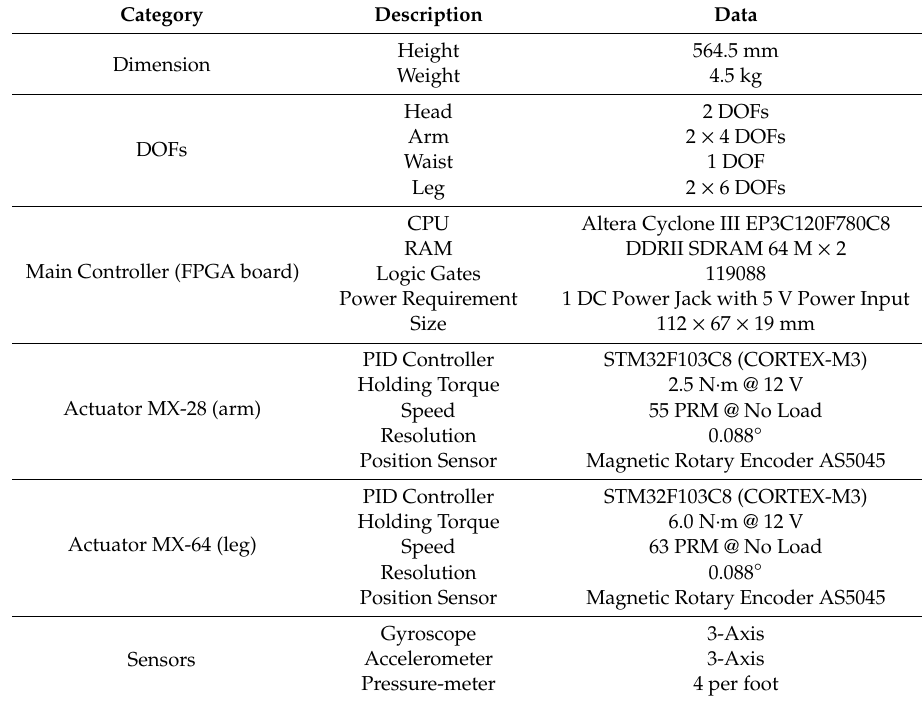
Figure 2. Dimensions of the TKU-X robot. ( a ) Whole body. ( b ) Soles of the feet. Table 1. Overall specifications of TKU-X.